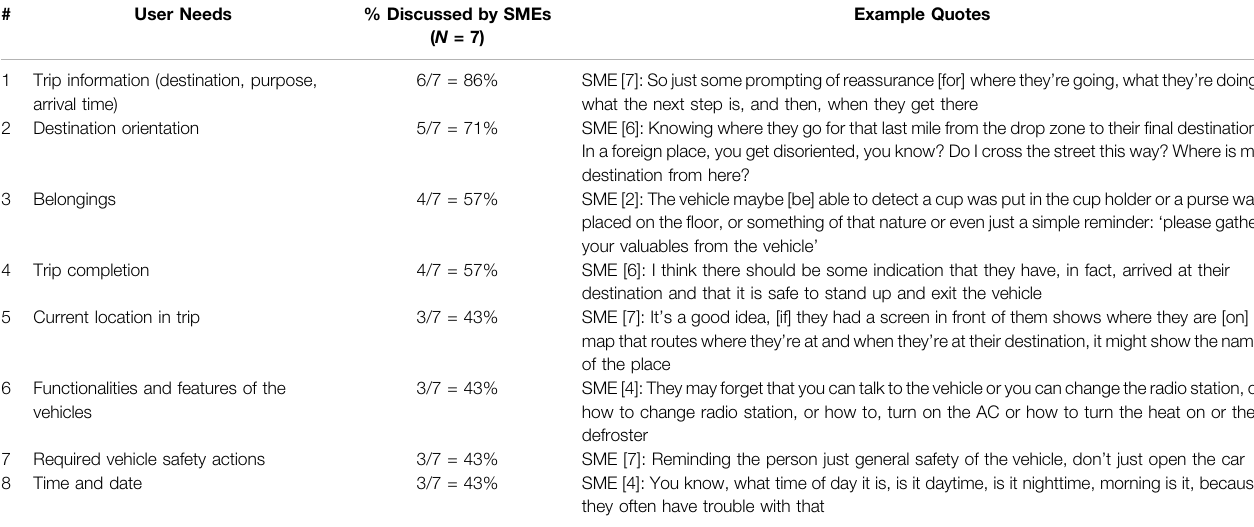
TABLE 2 | Common user needs identi fi ed by subject matter experts with examples.